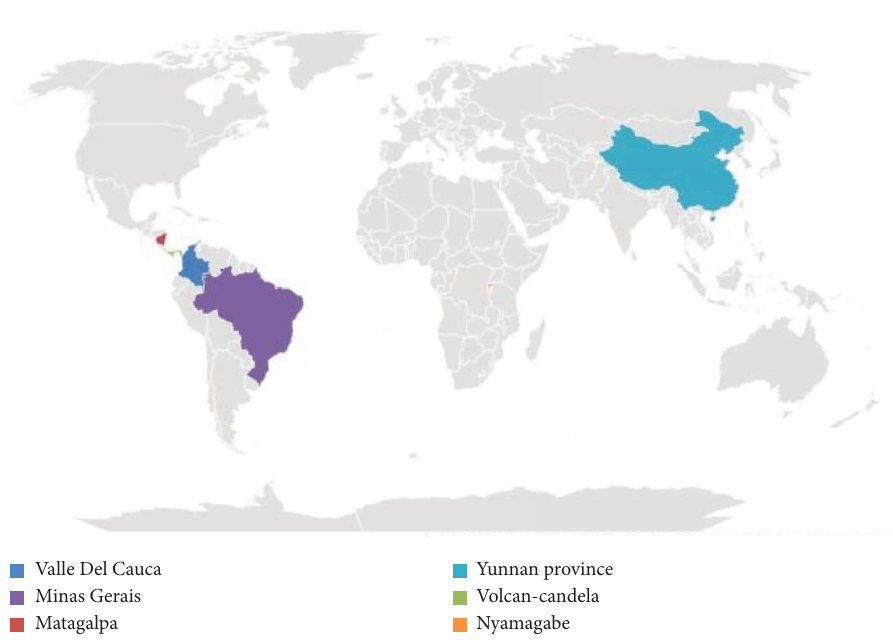
Figure 1: Te map of cofee bean samples from six geographical